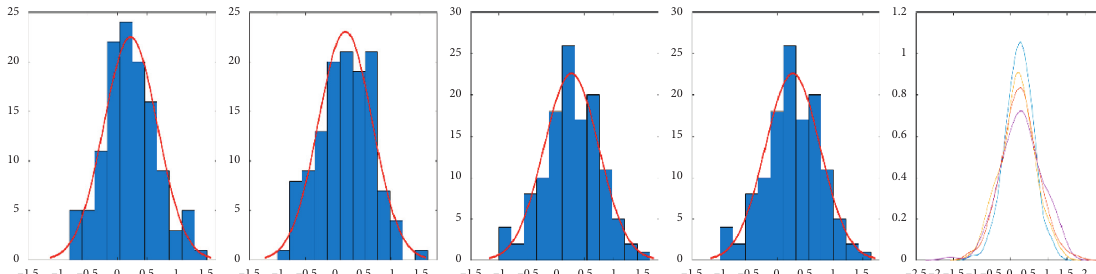
Figure 15: Standard deviation and normal distribution curve of pair 1, pair 2, pair 3, and pair 4.